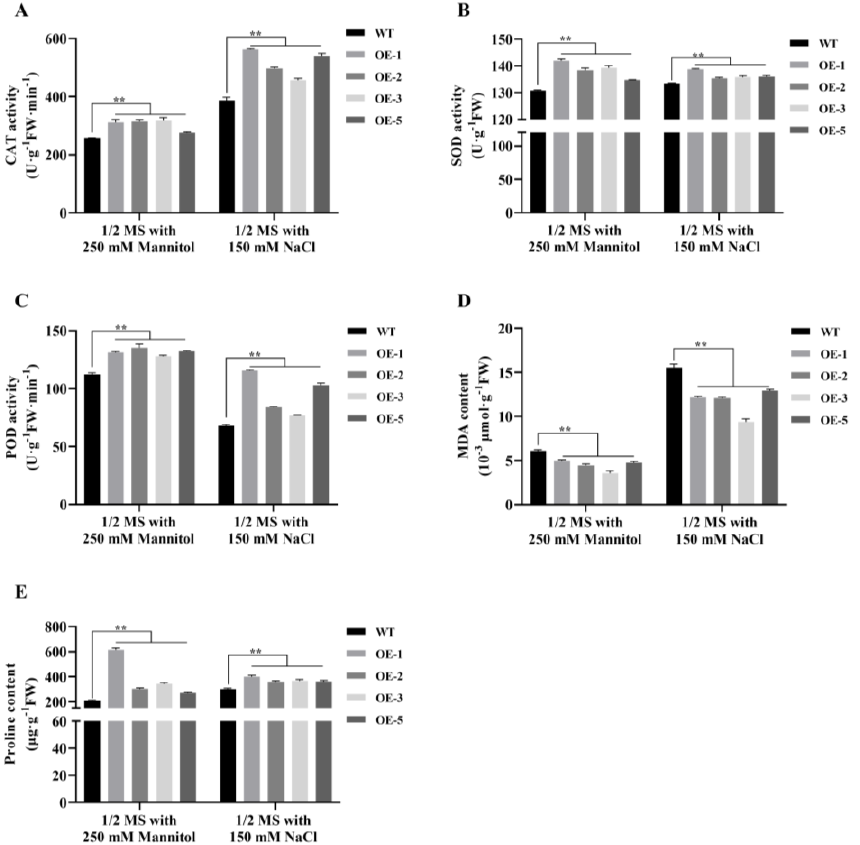
Figure 6. Antioxidant enzyme activity and the compatible solute concentration of MsNF-YB21 overexpression lines were obviously improved compared with WT under stress conditions. ( A ) CAT activity analysis. ( B ) SOD activity analysis. ( C ) POD activity analysis. ( D ) MDA content analysis. ( E ) Proline content analysis. Data are shown as the means ± SE from three replicates in each 50 representative plants used. Significant differences were assessed using Student’s t -test in comparison to WT (double asterisks denote p < 0.01).